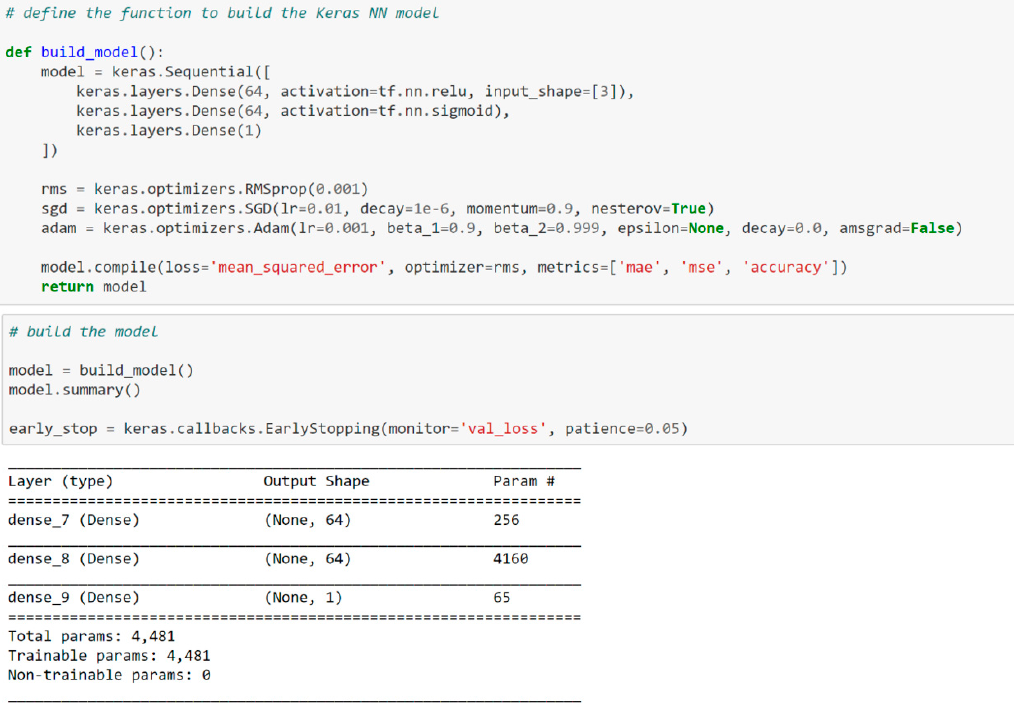
Figure 8. Running the training process using the linear regression algorithm.